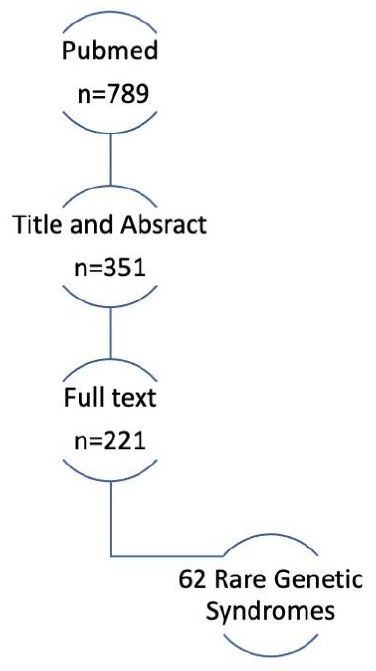
Figure 1. Flowchart.